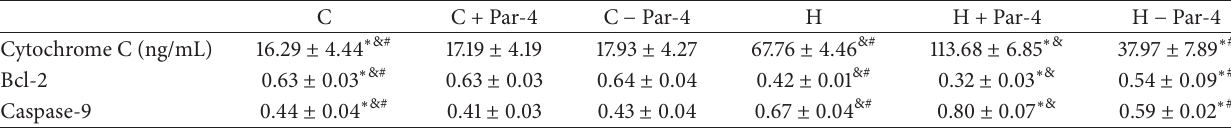
Table 5: The cytochrome C secretion and protein expression of Bcl-2 and caspase-9 of each group.